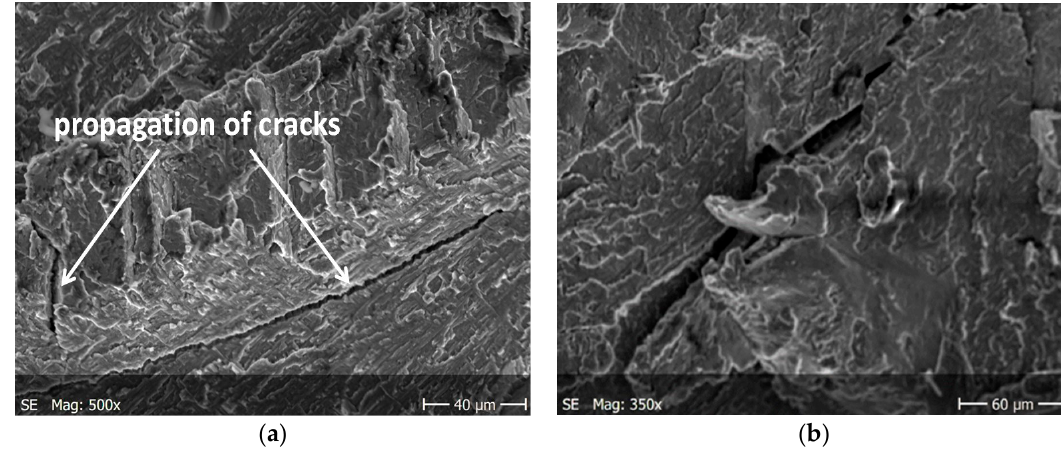
Figure 12. Cracking of O–Ti 2 AlNb alloy in specimen after cyclic tests for; ( a ) a larger specimen area, ( b ) enlarged crack.